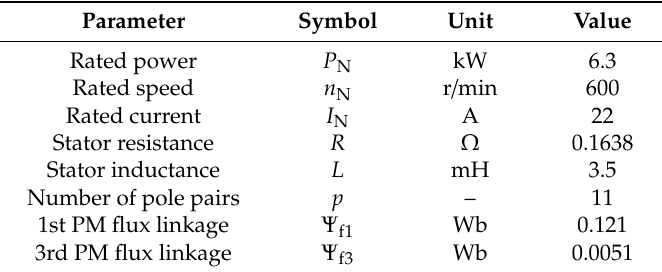
Figure 12. Fault-tolerant control system of five-phase PMSM under ITSC fault. Table 1. Parameters of five-phase PMSM. Table 1. Parameters of five-phase PMSM.